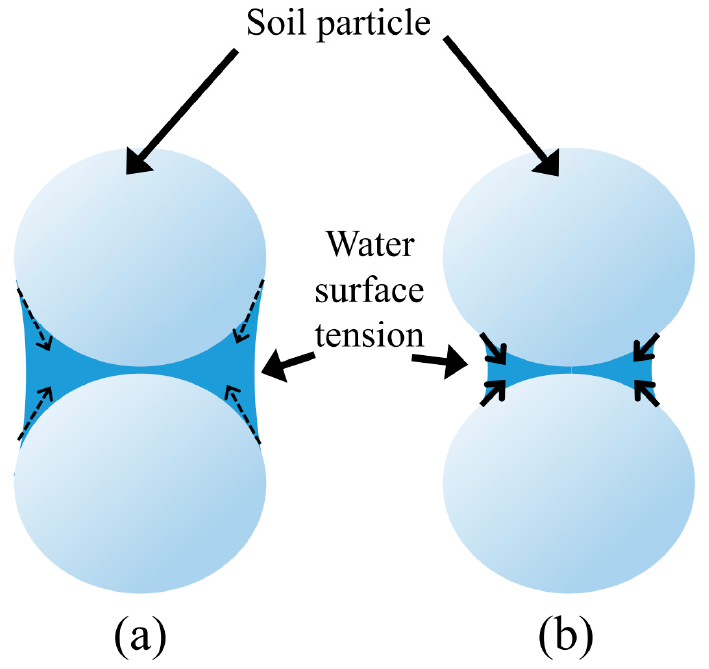
Figure 6. Interaction of water and soil particles: ( a ) a higher degree of saturation—lower surface tension forces, ( b ) lower degree of saturation—higher surface tension forces.